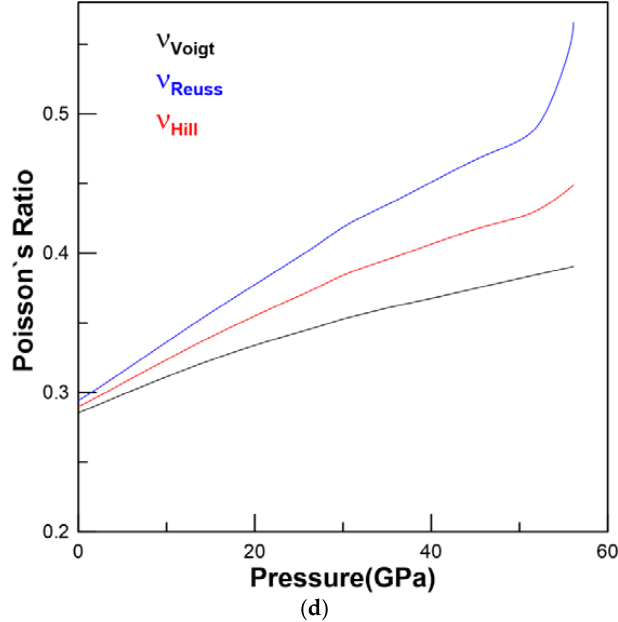
Figure 6. (Color online) ( a ) Pressure dependence of the bulk modulus, B . ( b ) Pressure dependence of the Young modulus, E. ( c ) Pressure dependence of the shear modulus, G. ( d ) Pressure dependence of the Poisson’s, ν , in the approximation of Voigt, Reuss and Hill.